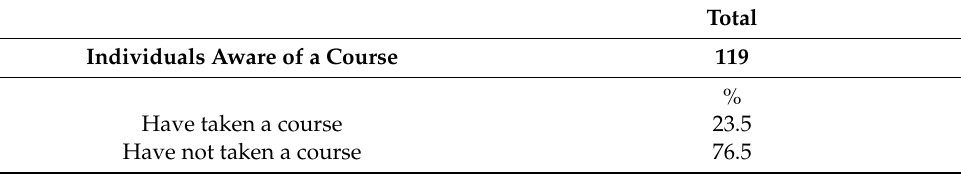
Table 4. Question 17: Have you taken any course or had any training on how to detect fake